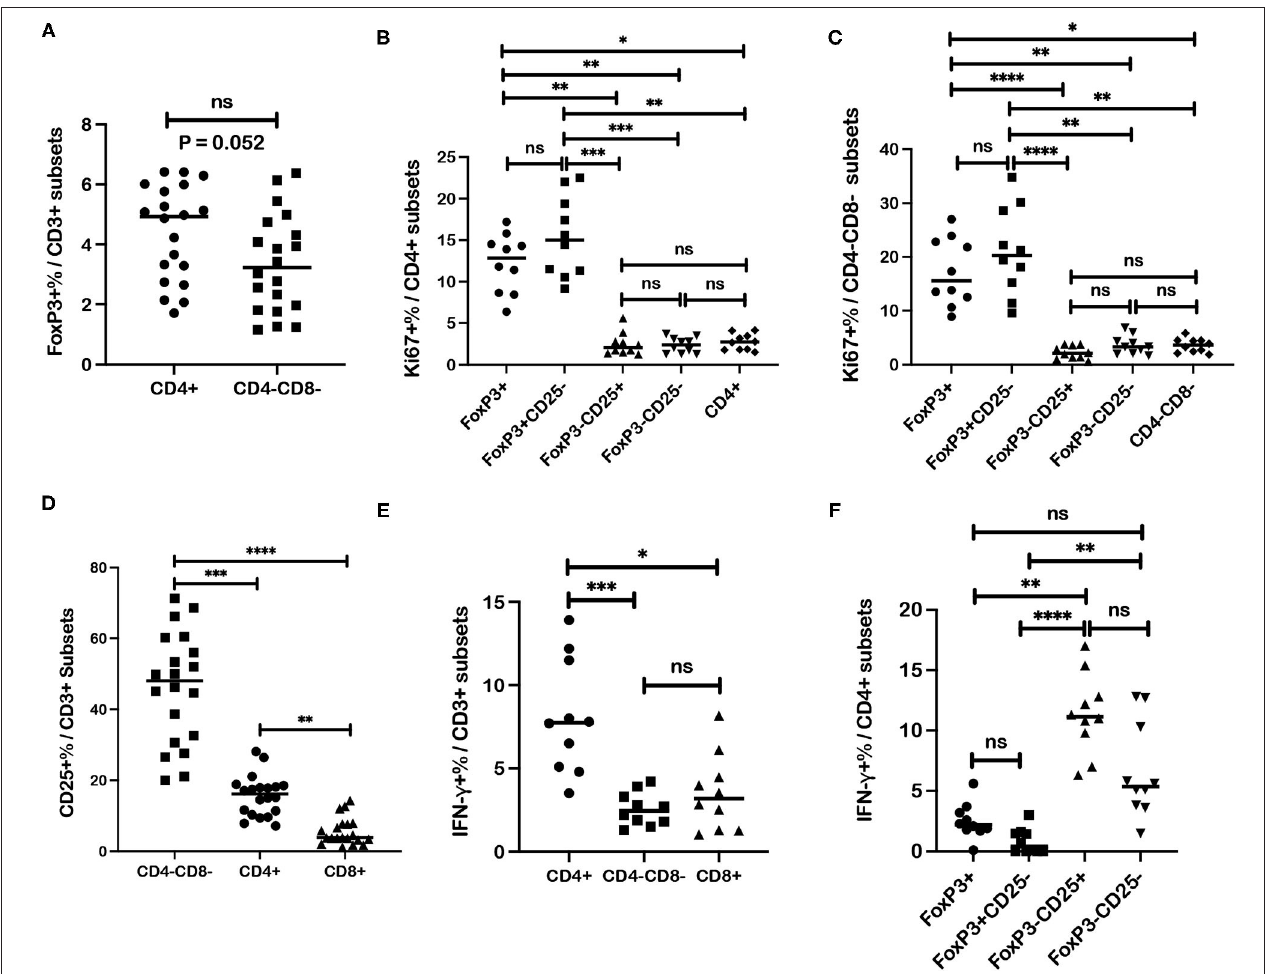
FIGURE 8 | Associations between regulatory and activation markers for specific T cell subsets in healthy dog PBMC. (A) Median frequencies of FoxP3 + cells are compared between CD4 + and CD4-CD8- T cell subsets. (B) Median frequencies of Ki67 + cells within different subsets of CD4 + T cells including regulatory (FoxP3 + ; CD25-FoxP3 + ), activated (CD25 + FoxP3-) and quiescent (CD25-FoxP3-) populations, are compared. (C) Median frequencies of Ki67 + cells within different subsets of CD4-CD8- T cells including regulatory (FoxP3 + ), activated (CD25 + FoxP3-) and quiescent (CD25-FoxP3-) populations, are compared. (D) CD4 + , CD4-CD8-, and CD8 + T cells subsets are compared for median frequencies of CD25 + cells. (E) Median frequencies of interferon- γ (IFN- γ ) + cells after ConA stimulation were compared between CD4 + , CD4-CD8-, and CD8 + T cells subsets. (F) Median frequencies of IFN- γ + cells after ConA stimulation were compared between different CD4 + T cell subsets including regulatory (FoxP3 + ; CD25-FoxP3 + ), activated (CD25 + FoxP3-) and quiescent (CD25-FoxP3-) populations. Values described for IFN- γ + frequencies reflect values for stimulated cells after subtraction of values for unstimulated cells. Comparisons of frequencies between three more subsets were performed with a Kruskal-Wallis test with Dunn’s post-hoc test for multiple comparisons. Pair-wise analysis between frequencies of two subsets (A) was conducted with the Mann Whitney test and two-tailed analysis. All analyses used GraphPad Prism software. “ns” denotes not significant. A single asterisk (*) denotes a P -value < 0.05; two asterisks (**) denote a P -value < 0.01; three asterisks (***) denote a P -value < 0.001 and four asterisks (****) denote a P -value < 0.0001. P -values < 0.05 are considered